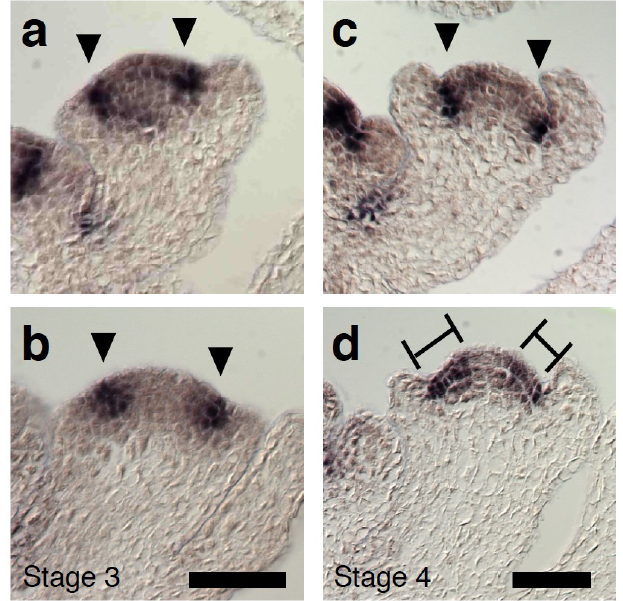
Figure 5. Altered CUC2 gene expression in LFY loss-of-function flowers. ( a – d ) CUC2 expression in wild-type ( a , c ) and lfy ( b , d ) flowers at stage 3 ( a , b ) and stage 4 ( c , d ). Arrowheads denote the boundary between the floral meristem and the sepals. Bars indicate diffused CUC2 expression. Scale bar, 25